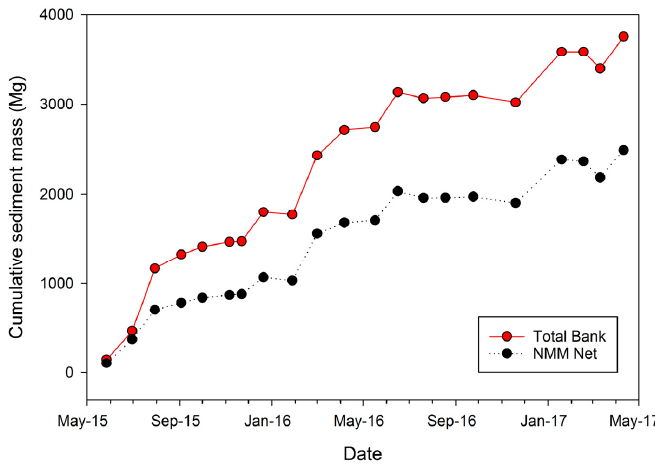
Figure 10. Cumulative mean sediment mass loss for NMM Net and total bank, for the main stem of Walnut Creek, Iowa.